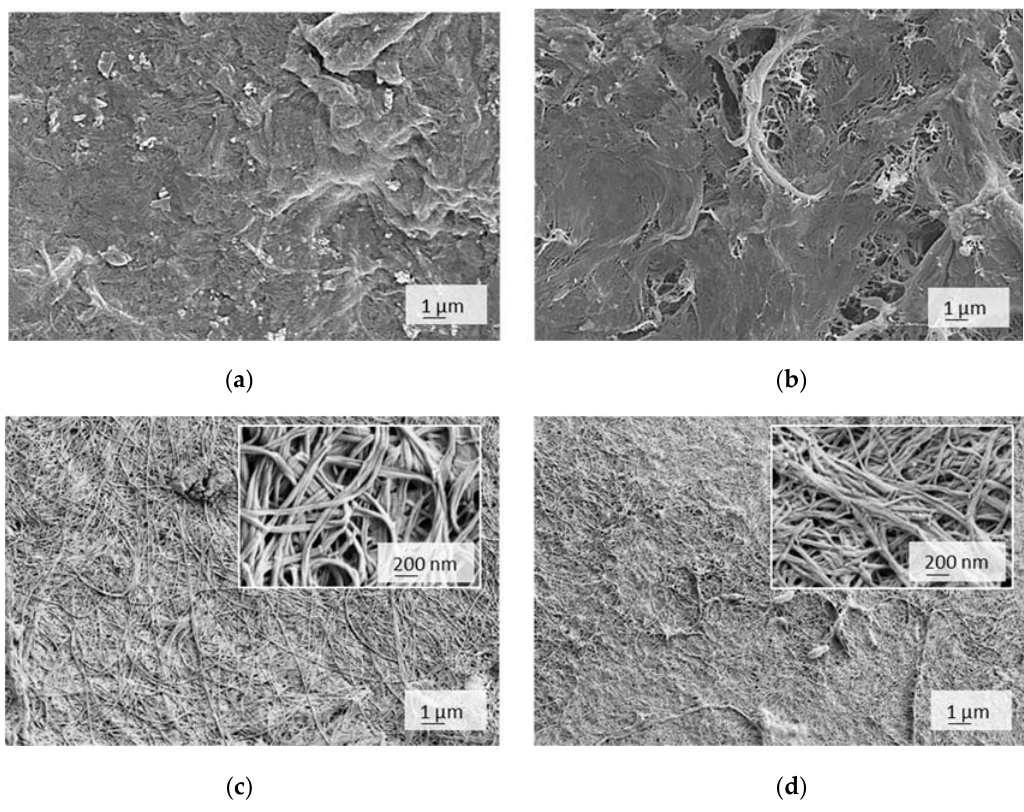
Figure 6. SEM micrographs of cellulose membranes, designated as ( a ) 4CNF / 4CMC, ( b ) 7CNF / 1CMC, ( c ) BC and ( d ) BCox, depicted in a dry state.